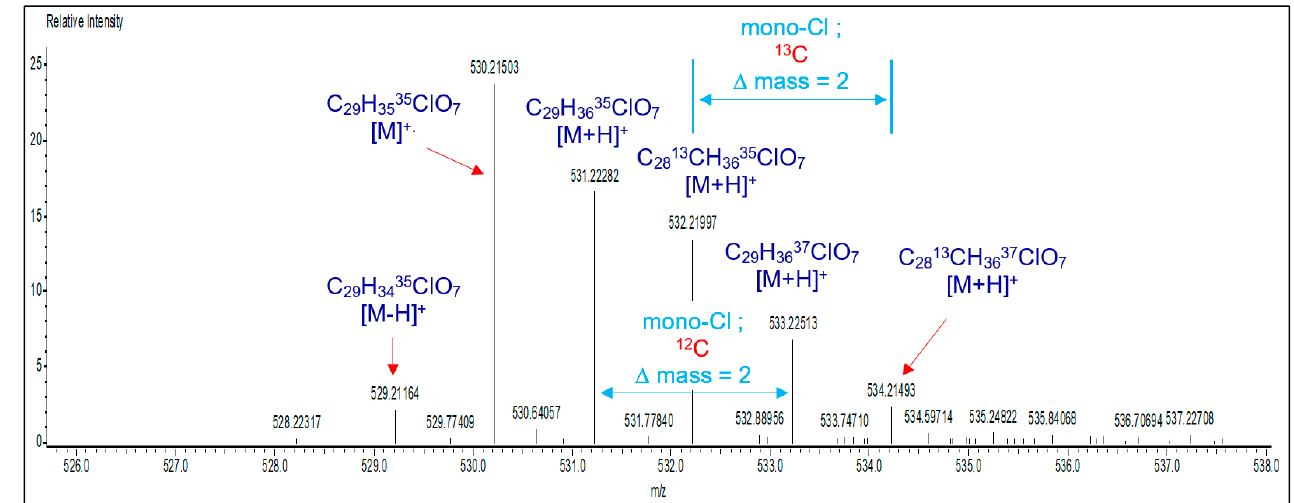
Figure 5. Direct analysis of mCl-BisGMA monomer in real-time mass spectroscopy (DART-MS).